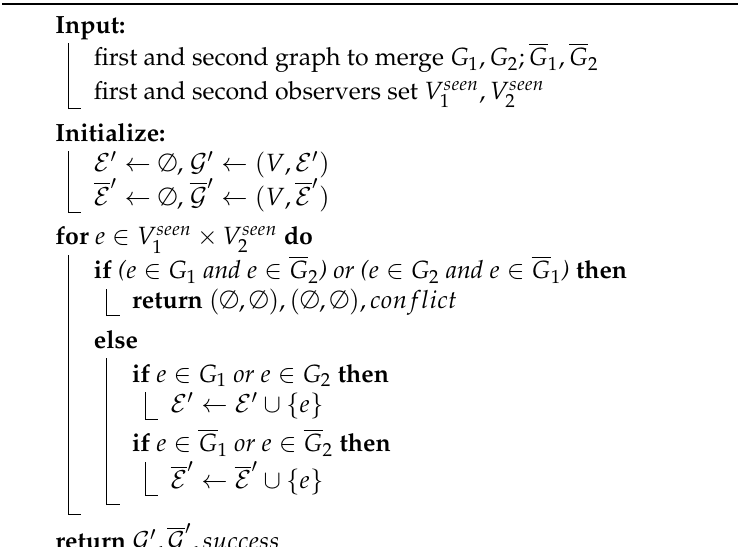
, G 2 , G 2 , V seen 2 1